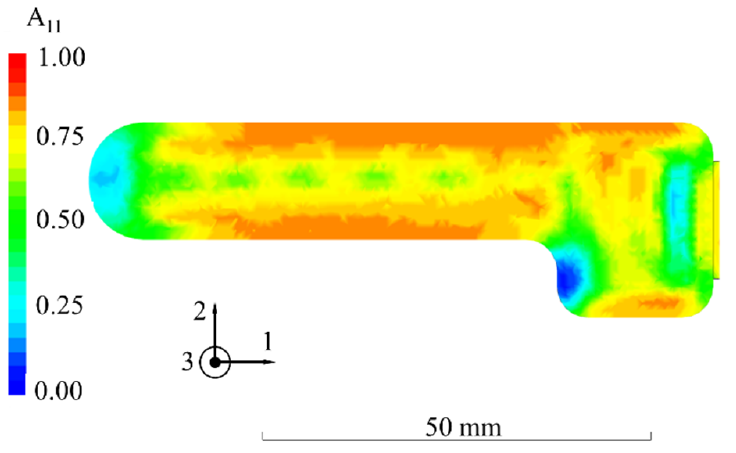
Figure 4. The simulated volumetric shrinkage ( a ) and the deviation between injected door handle and mould cavity according to GOM measurements ( b ).